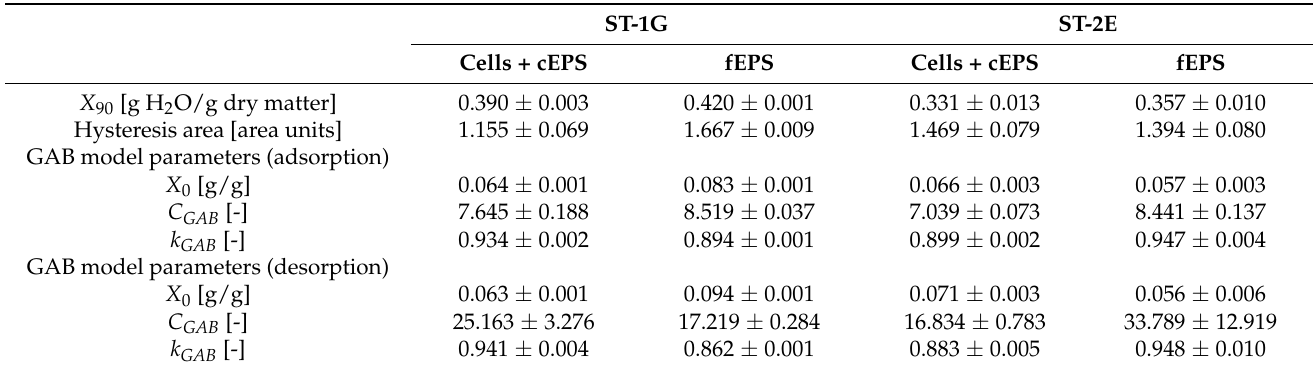
Table 4. Moisture load at r.h. = 90% ( X 90 ), hysteresis area between adsorption and desorption isotherms and Guggenheim–Anderson–De Boer (GAB) equation parameters X 0 , k GAB and C GAB for adsorption and